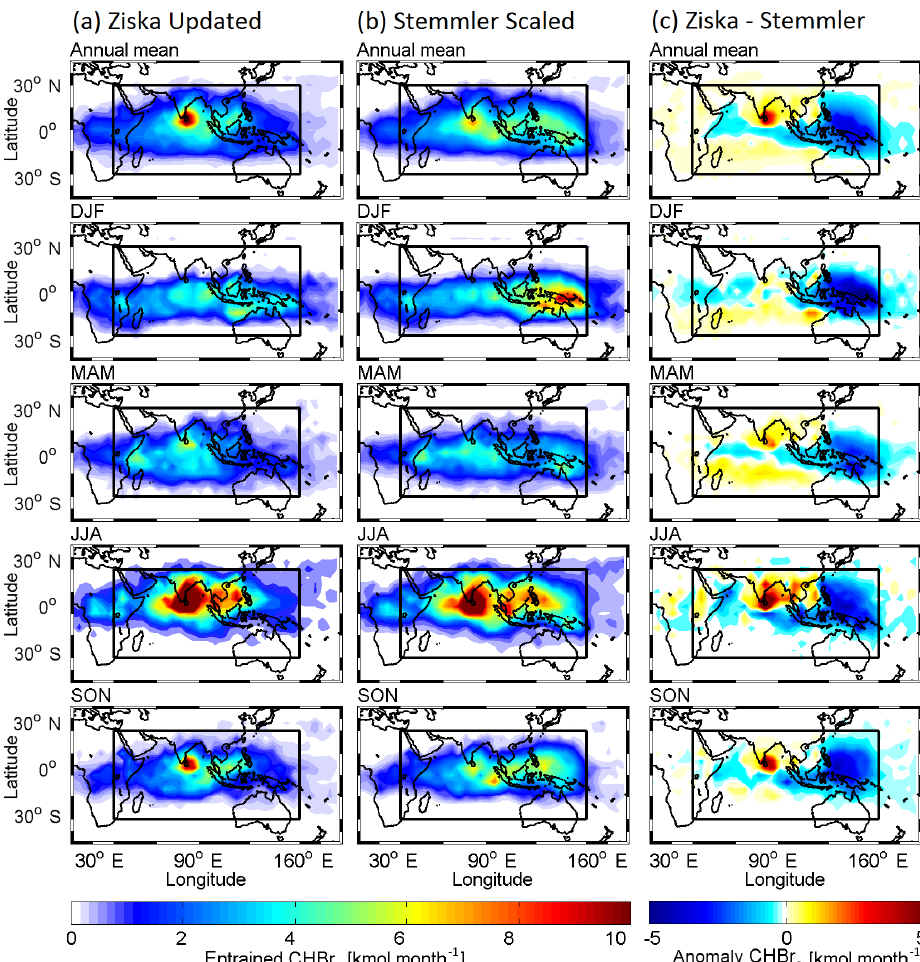
Figure 5. Amount of CHBr 3 injected to the stratosphere within 1 ◦ × 1 ◦ grid cells plotted on the geographical location of CPT crossing for monthly averaged bromoform emissions for (a) Ziska Updated and (b) Stemmler Scaled emission inventories. (c) Differences in injection between the two inventories (a) minus (b) . The black box depicts the Indian Ocean and west Pacific release